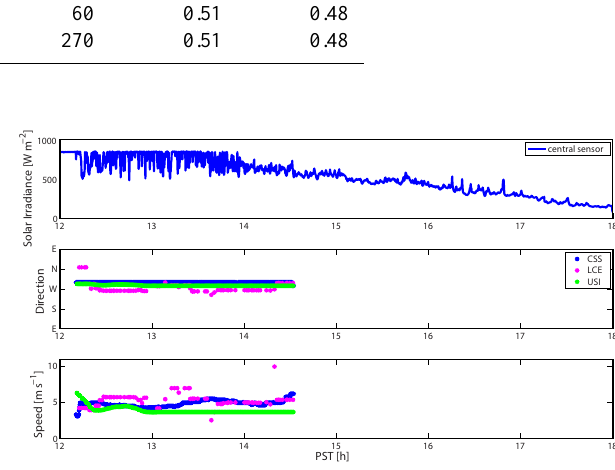
Figure 6. Solar irradiance and CMVs from CSS, USI, and LCE for 23 July. Luminance measurements of the central TEPT4400 sensor were calibrated against a colocated pyranometer to obtain Wm − 2 of solar